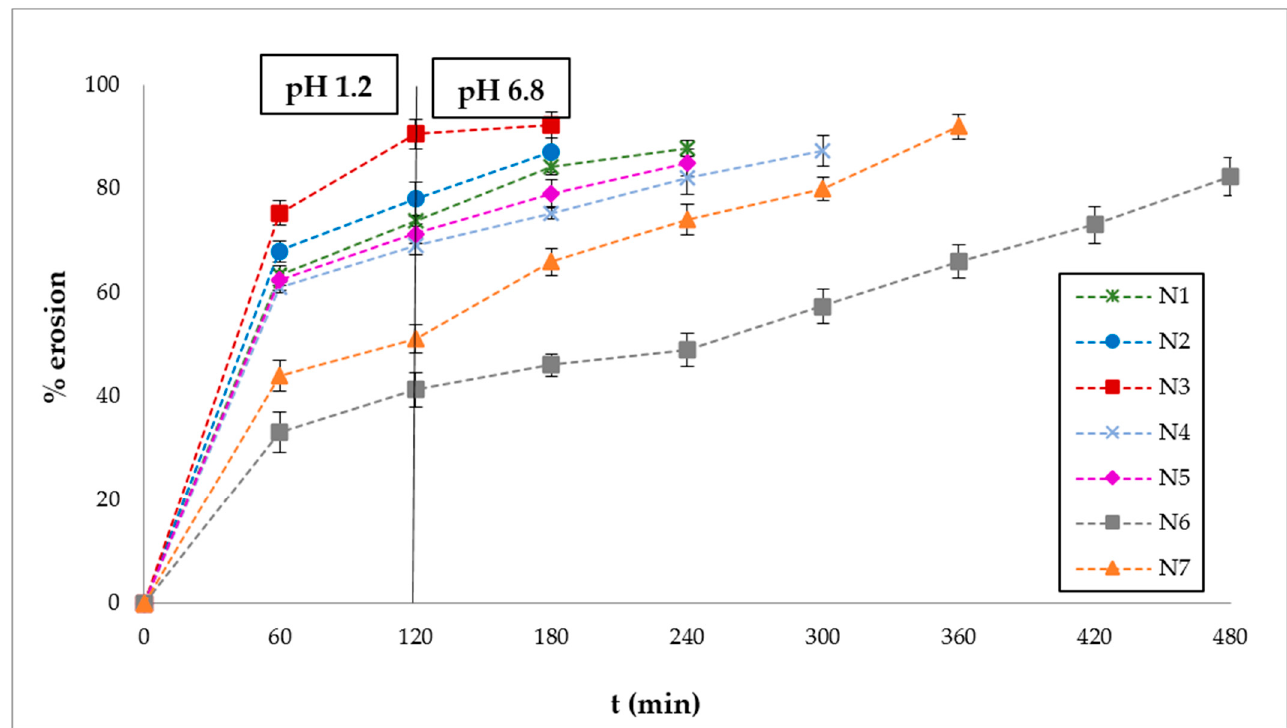
Figure 4. % Erosion of BUP·HCl tablets formulations vs. time at pH 1.2 (0–120 min) and at pH 6.8 (120–480 min). The results denote the mean value ( n = 6).